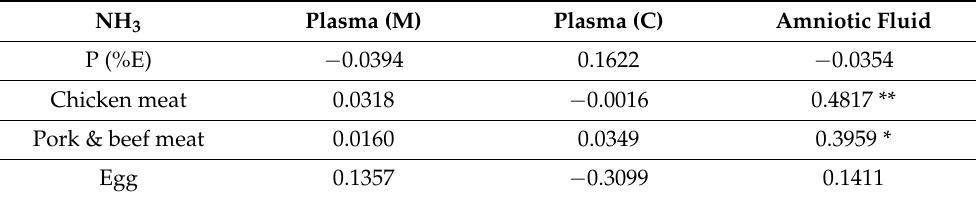
Table 4. Spearman rank correlation coefficients between dietary protein, meat, and egg intake and ammonia concentration in maternal plasma, cord blood plasma, and amniotic fluid